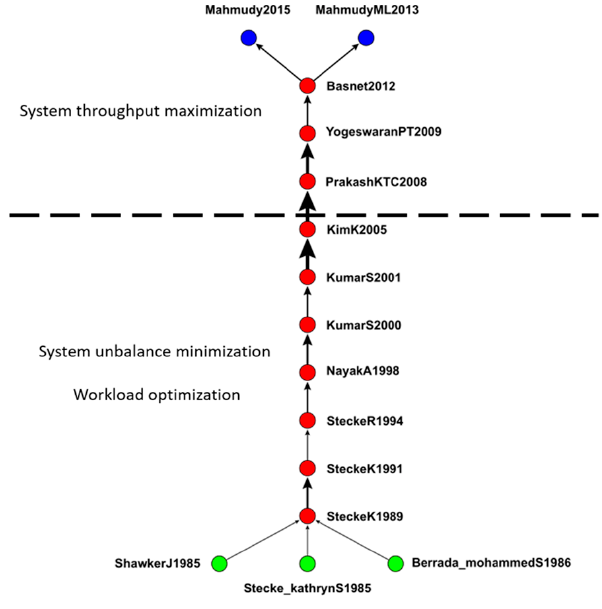
Figure 5. Global main path of solving loading problems through scheduling.